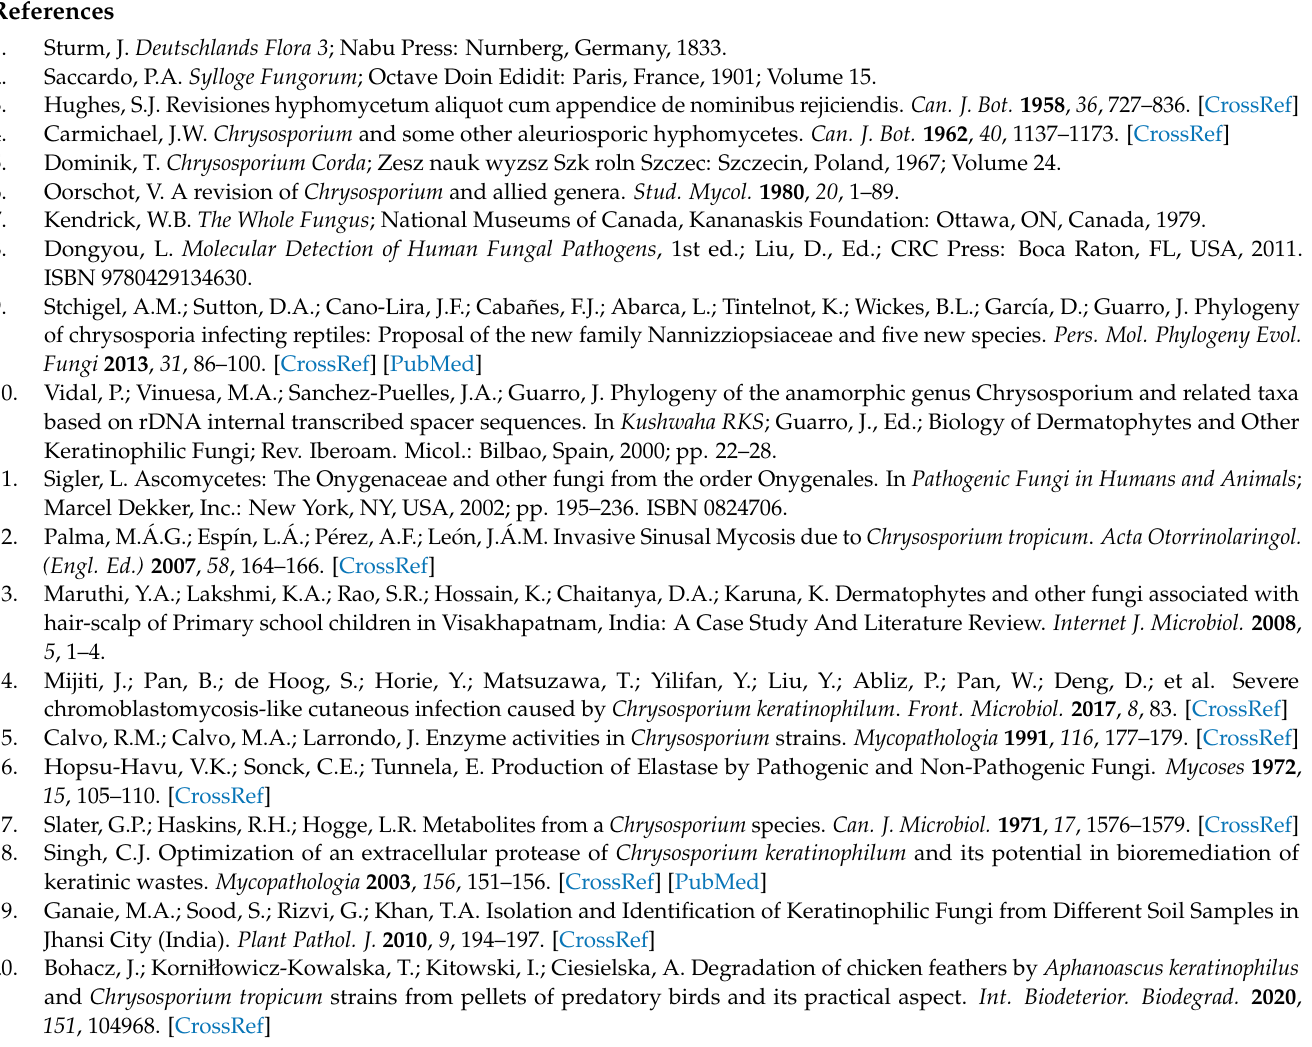
Table S3: Identified superfamily in the C. keratinophilum CBS 104.62 genome; Table S4: Summary of superfamily in the C. keratinophilum CBS 104.62 genome; Table S5: Identified CAZymes in the C. keratinophilum CBS 104.62 genome; Table S6: Identified CAZymes in the C. keratinophilum CBS 104.62 genome for each family; Table S7: Identified PHIs in the C. keratinophilum CBS 104.62